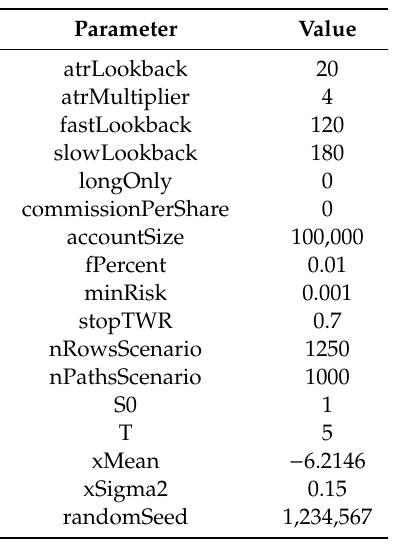
Table 1. Parameter values.